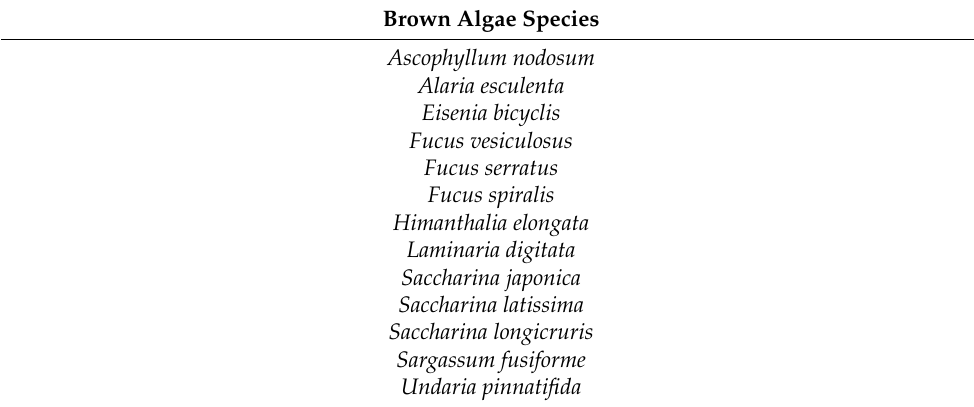
Table 1. List of brown algae species for human food applications in Europe under the regulation (UE) 2015/2283